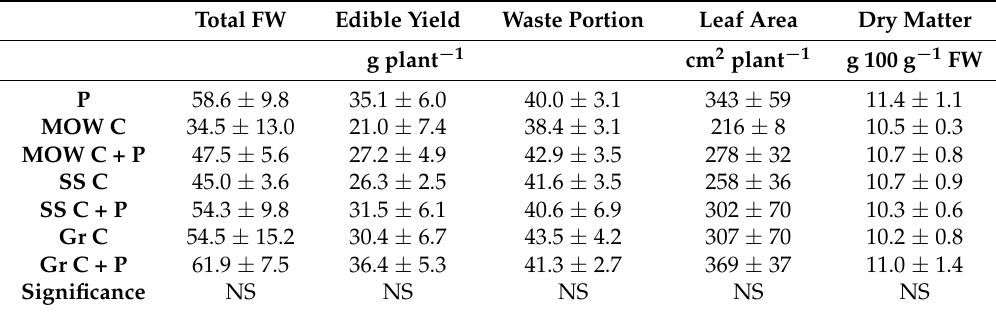
Table 2. Total shoot fresh weight (FW), edible yield, waste portion, leaf area and dry matter of sea fennel grown on seven substrates composed of peat and three different composts containing posidonia residues. A peat-based commercial substrate was used as control. The compost materials were tested alone or in mixture with peat (at a rate of 50% on a volume